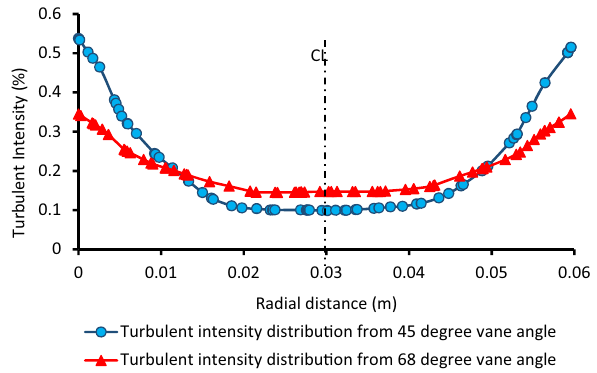
Fig. 12 Radial distribution of turbulence intensity at Z = 90 mm of the LLHC for 45° and 68° with an inlet velocity of 2 m/s